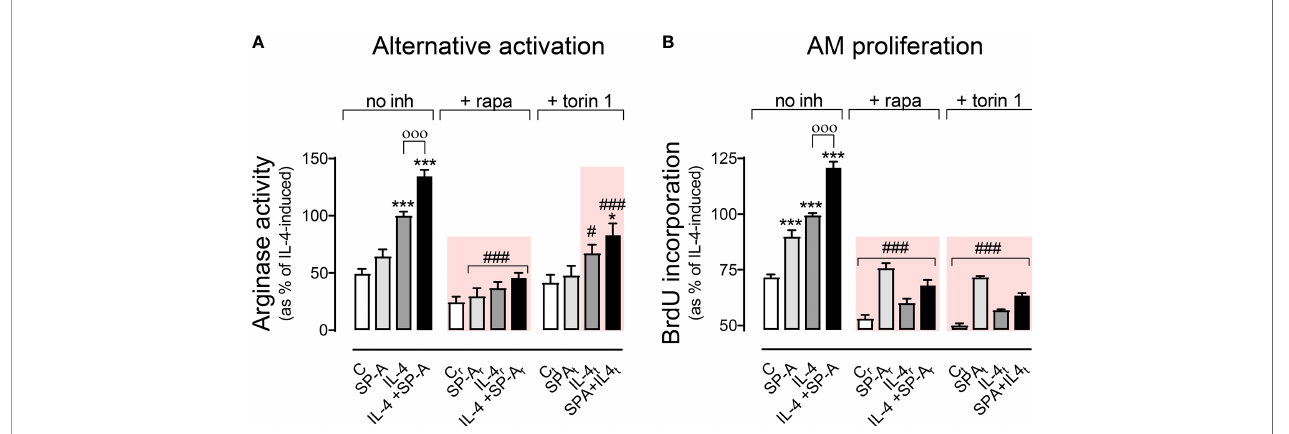
FIGURE 5 | Effect of pharmacological inhibition of mTORC1 on arginase activity and AM proliferation. Puri fi ed rat AMs were pretreated with 20 nM (A) or 5 nM (B) rapamycin, 100 nM (A) or 25nM (B) torin 1, or vehicle (DMSO) for one hour. Cells were then stimulated with or without IL-4 and/or SP-A and arginase activity (A) and AM proliferation (B) were measured. The results are presented as means (± SEM) from three different AM cultures with at least three biological replicates. ANOVA followed by the Bonferroni multiple-comparison test was used. *p < 0.05 and *** p < 0.001 when compared with untreated macrophages. ооо p < 0.001 when SP-A+IL-4-treated macrophages were compared with IL-4-treated macrophages. # p < 0.05 and ### p < 0.001 when the effect of either rapamycin or torin1 is compared with the same sample without